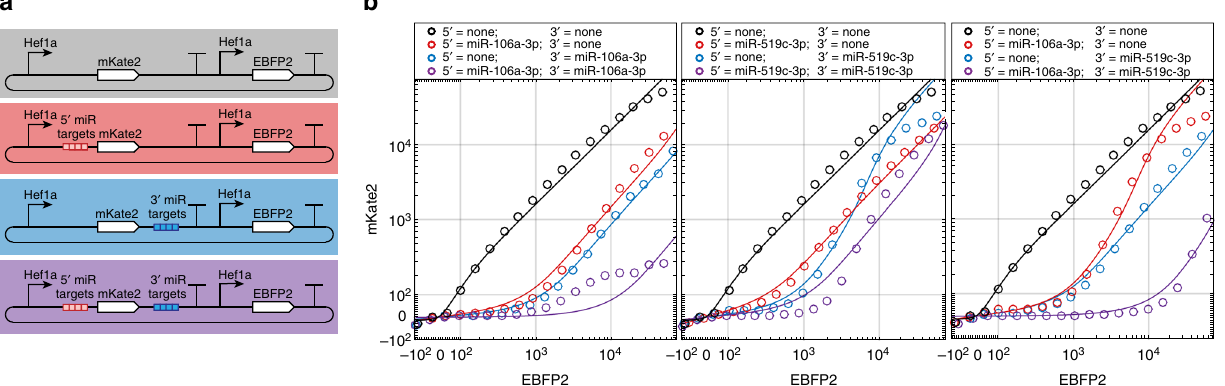
Fig. 4 Positioning miRNA target site sets in separate UTRs yields synergistic interactions. a Diagram of tested constructs bearing target sites in 5 ′ UTR only (red), 3 ′ UTR only (blue), both 5 ′ and 3 ′ UTRs (purple), and no target sites (gray; shown as black in b ). Constructs were designed to sense endogenous miRNAs with detectable activity in the tested cell line (HEK293FT). b miRNA repression data (circles) and model fi ts (lines) obtained for each of the four constructs with miR-106a-3p target sites, miR-519c-3p target sites, or a combination of the two. Constructs bearing target sites in both 5 ′ and 3 ′ UTRs showed greater repression than constructs with target sites in only a single UTR, demonstrating a synergistic effect not observed in constructs where target site sets were con fi ned to the 3 ′ UTR